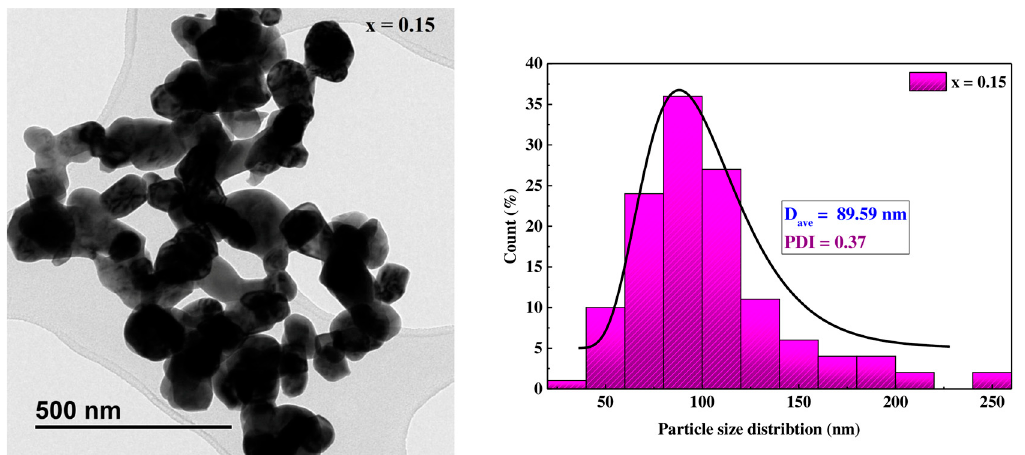
Figure 4. SEM Micrographs of Pr (cid:2868).(cid:2875) Sr (cid:2868).(cid:2871) Mn ((cid:2869)(cid:2879)(cid:2934)) Co (cid:2934) O (cid:2871) (0 ≤ x ≤ 0.15) samples.